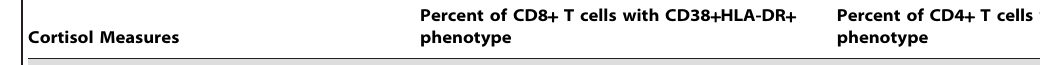
Cortisol Measures